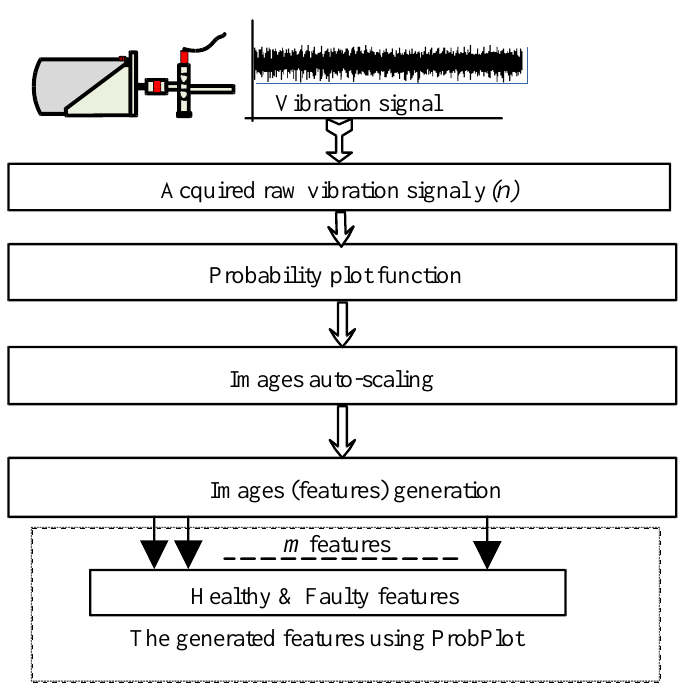
Figure 2. ProbPlot-based features generation flowchart procedure in Matlab.